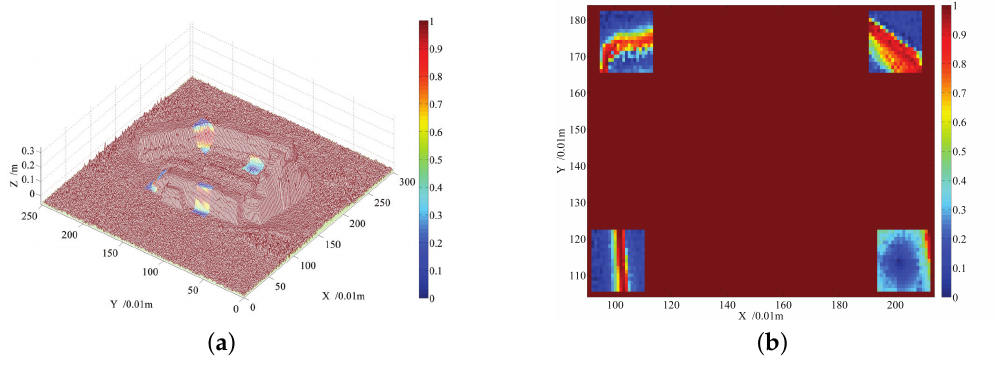
Figure 11. The cost map for candidate footholds in the real world. ( a ) Cost of candidate footholds represented in a 2.5D elevation map. ( b ) Cost of candidate footholds represented in the projected 2D